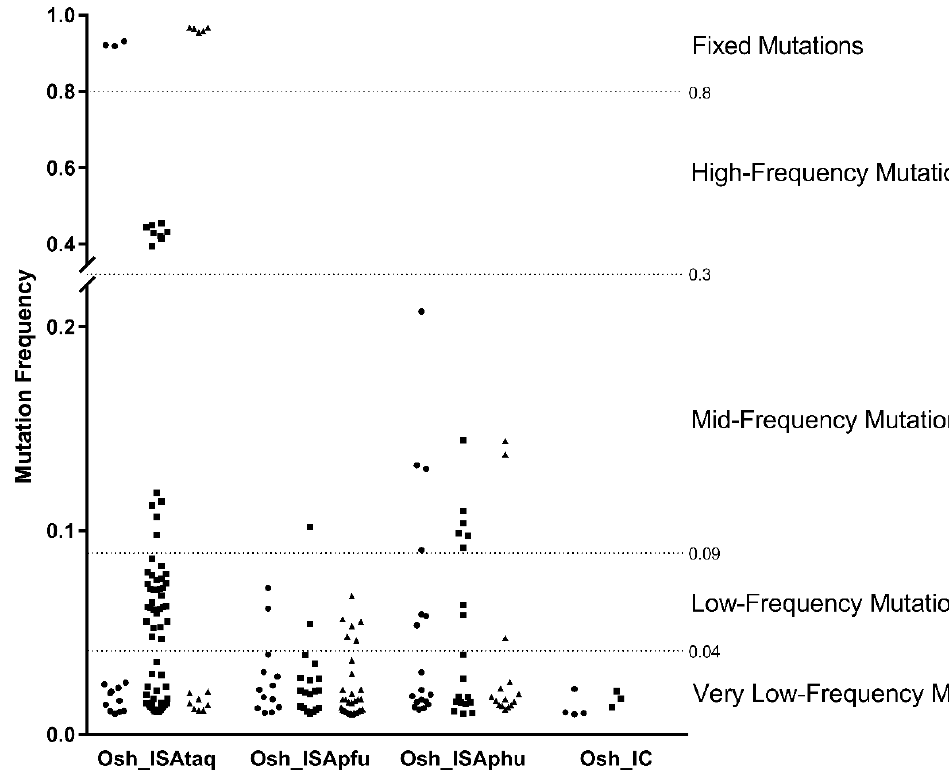
Figure 1. Genetic diversity of viral populations. The complete genome sequence of each virus was determined in triplicate. All substitutions detected with a frequency of at least 1% are represented by circles, squares, or triangles, which correspond to the first, second, and third replicates, respectively. Five mutation categories were defined according to frequency distribution. No mutation was detected for the third replicate of the Osh_IC virus.